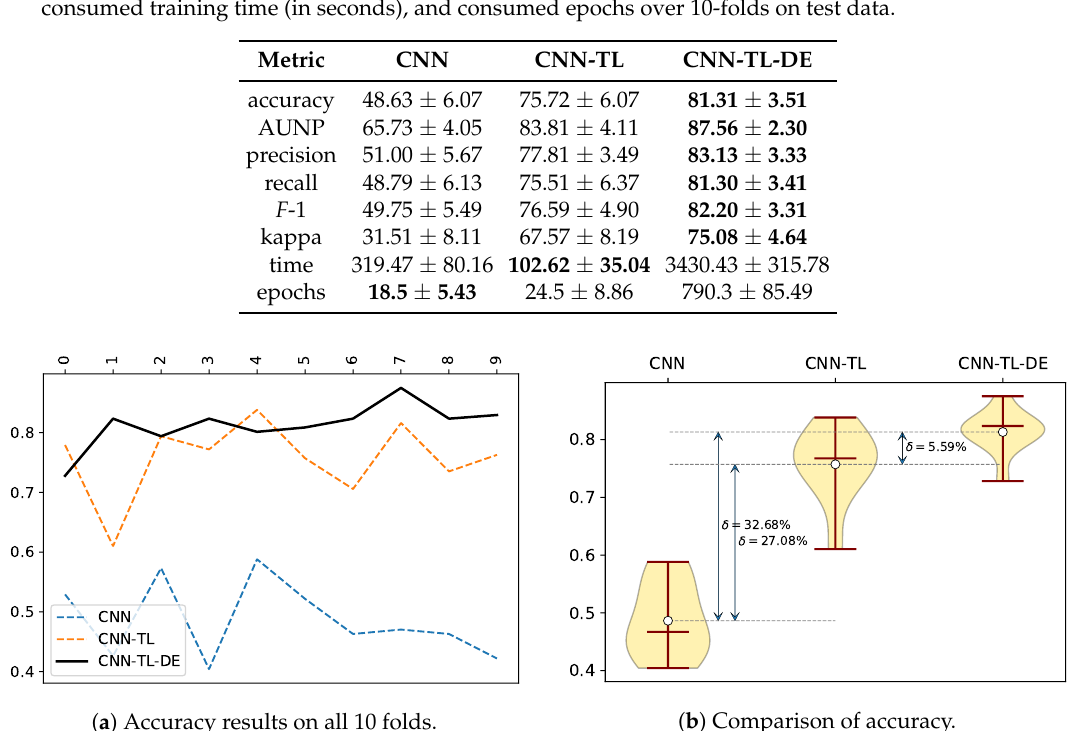
Table 4. Comparison of average accuracy, AUNP, precision, recall, F -1 score, kappa coefficient, consumed training time (in seconds), and consumed epochs over 10-folds on test data.